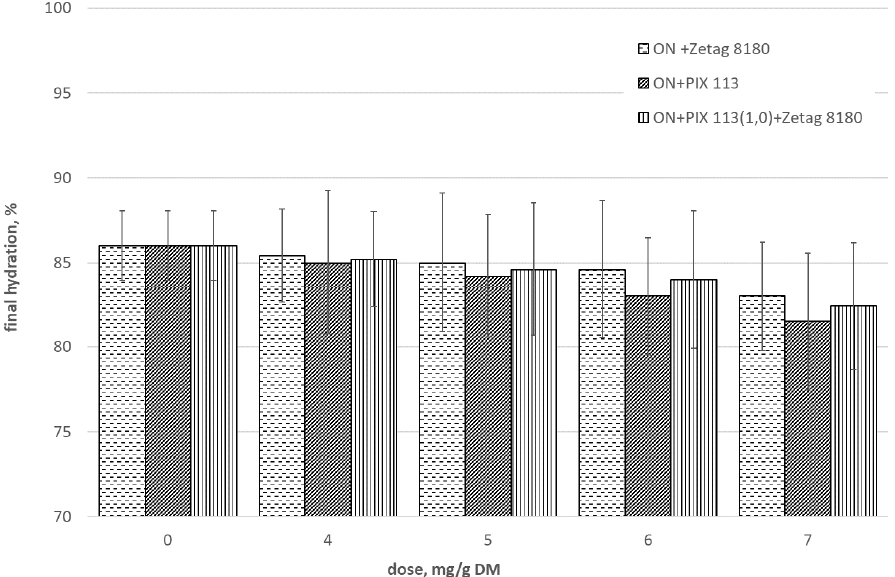
Figure 4. Effect of the dose of selected chemicals on SFR of sonicated sludge (A 2 = 45.75 µm). The effects of dewatering of the sonicated sludge prepared with chemical reagents: Zetag 8180, PIX 113 and combined ones are shown in Figures 5 and 6.